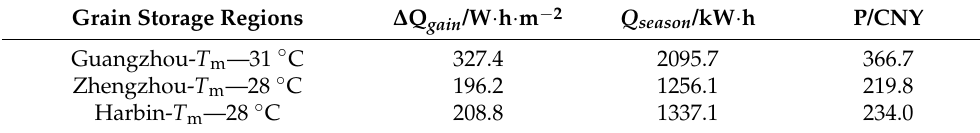
Table 6. The economy analysis of PCM bin walls in different grain storage regions [36]. Grain Storage